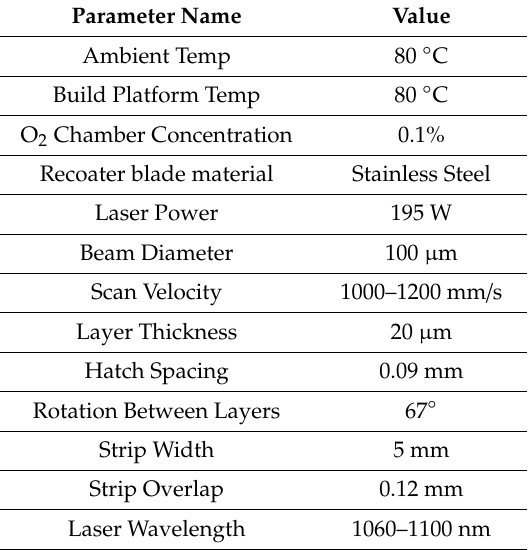
Table 1. Process parameters used in L-PBF processing of Powders A and